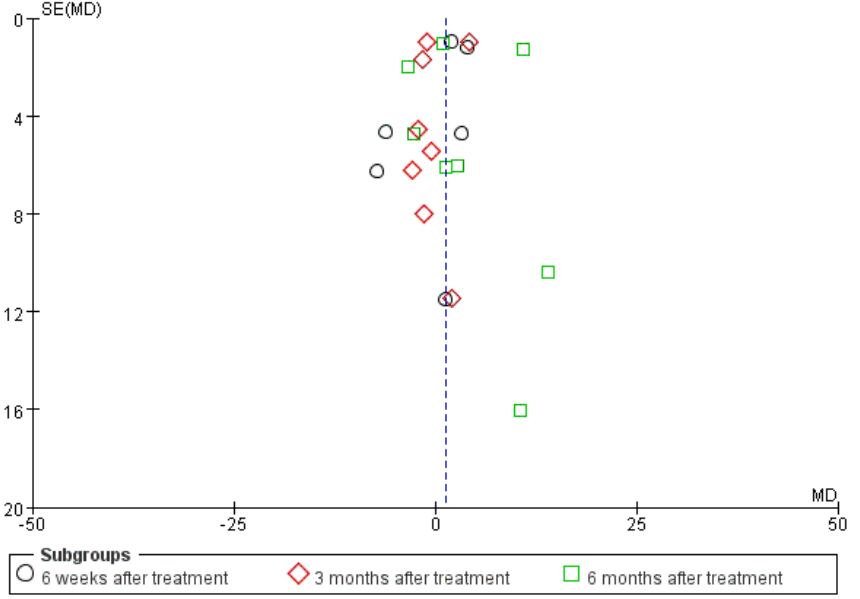
Figure 4. Funnel plot based on the Victoria College Ankle Function Scale scores from eight studies of Achilles